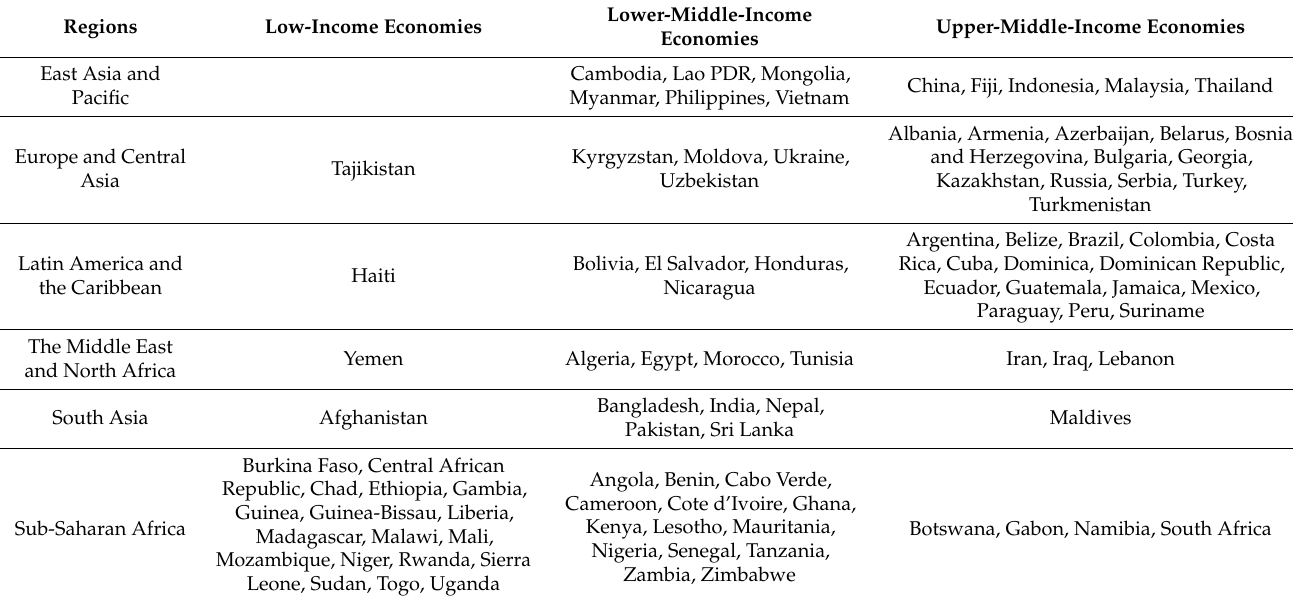
Table 4. Countries included in the study.